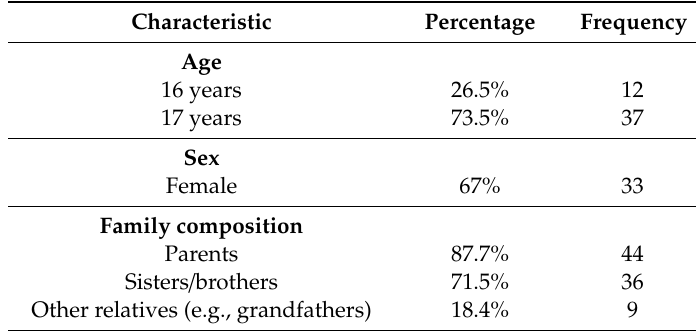
Table 3. Characteristics of the 49 co-producer students who participated in